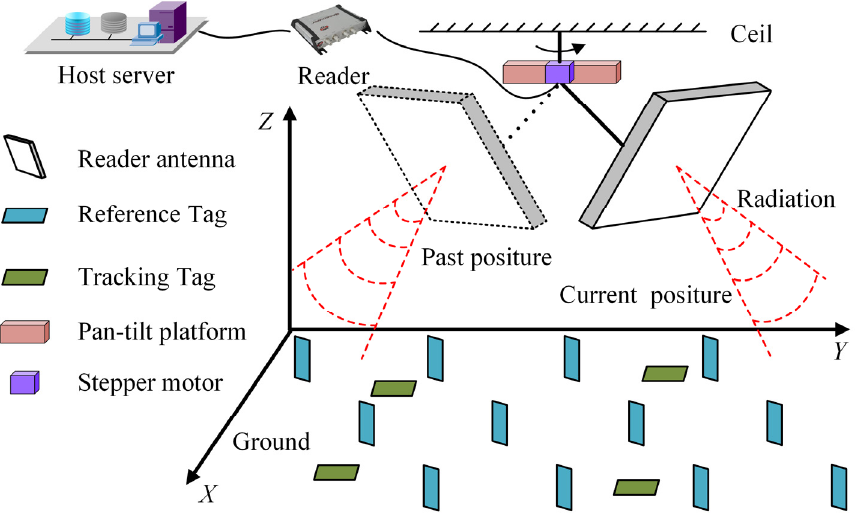
Figure 1. An illustrative diagram of the ultra high frequency radio frequency identification (UHF RFID) localization system performed under a directional radiation scenario.